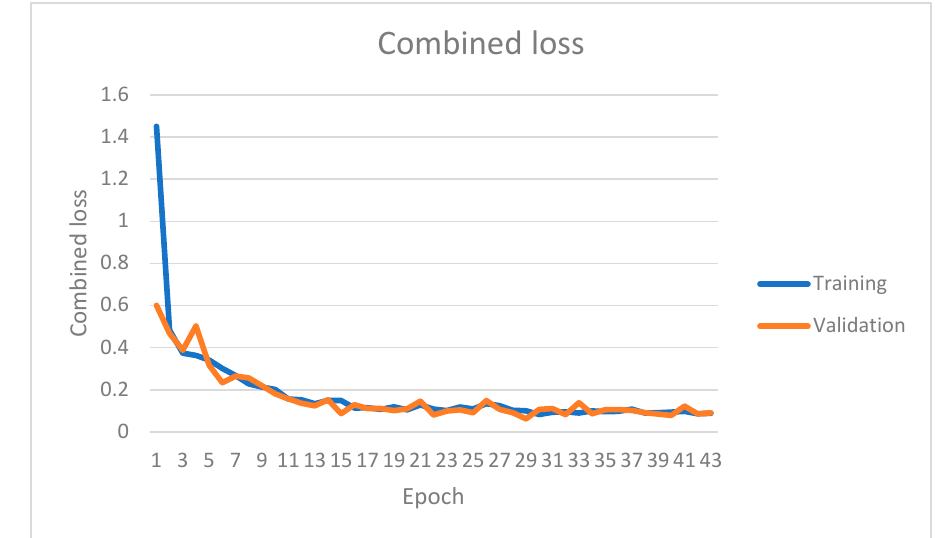
Figure 7. Instance segmentation combined loss on both the training and validation datasets over different epochs.